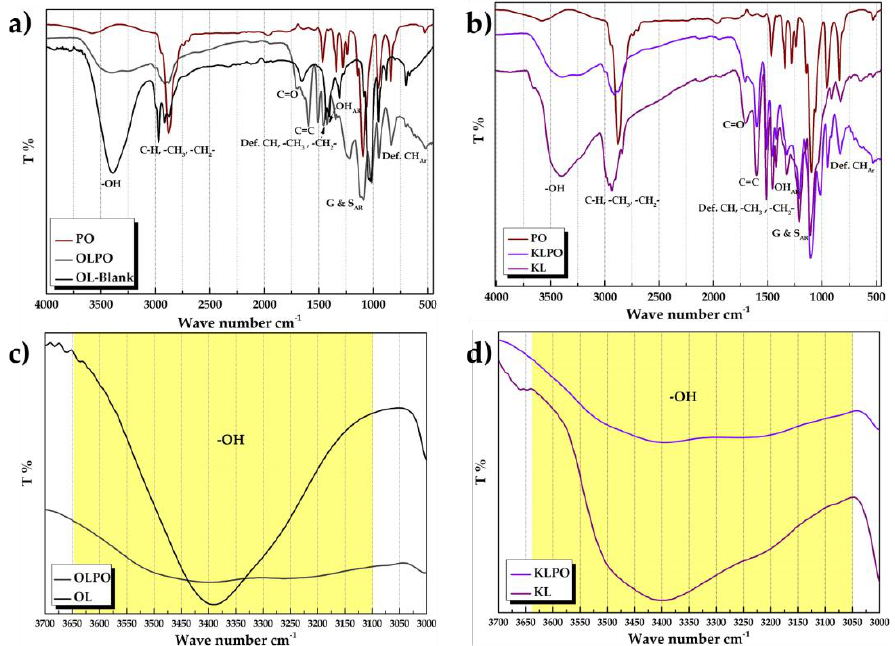
Figure 4. FTIR (Fourier transform infrared) spectra ( a ) Organosolv lignin-PEO (polyethylene oxide) (OLPO) composite in comparison to PEO (PO) and blank organosolv lignin (OL), ( b ) comparison of OLPO and OL to demonstrate shift in peak in the range of 3000–4000 cm −1 , ( c ) Kraft lignin-PEO (KLPO) composite in comparison to PEO (PO) and blank kraft lignin (KL), ( d ) comparison of KLPO and KL to demonstrate shift in peak in the range of 3000–4000 cm −1 .